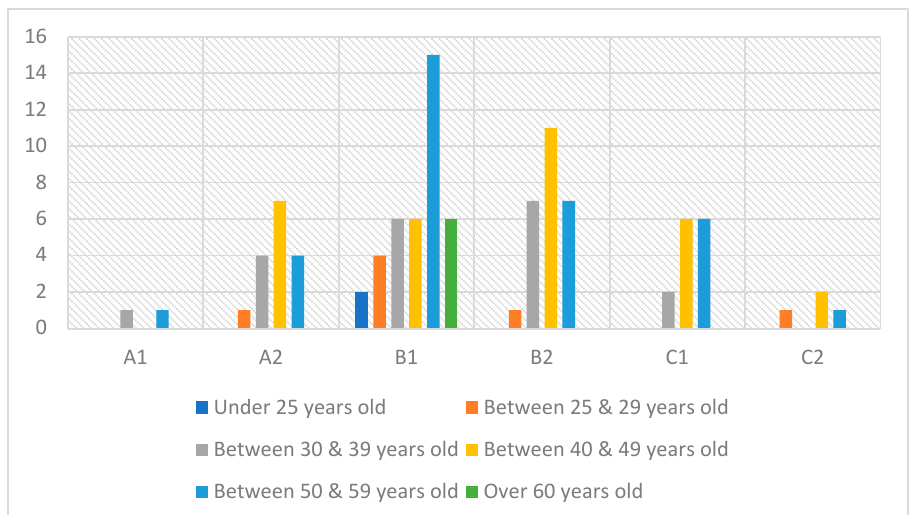
Figure 3. Level of Digital Competence by Age.